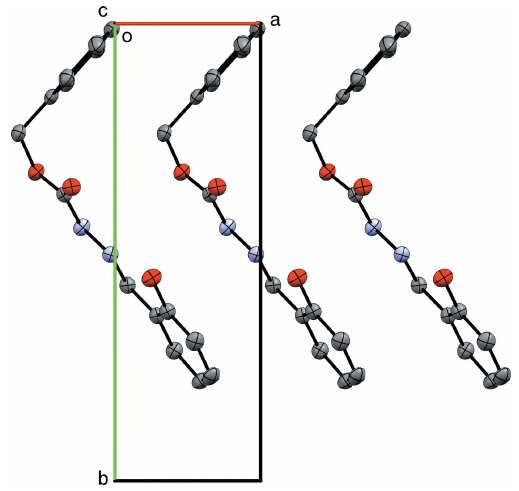
Figure 4 V-shaped molecules of I stack into columns parallel to the a -axis direction.